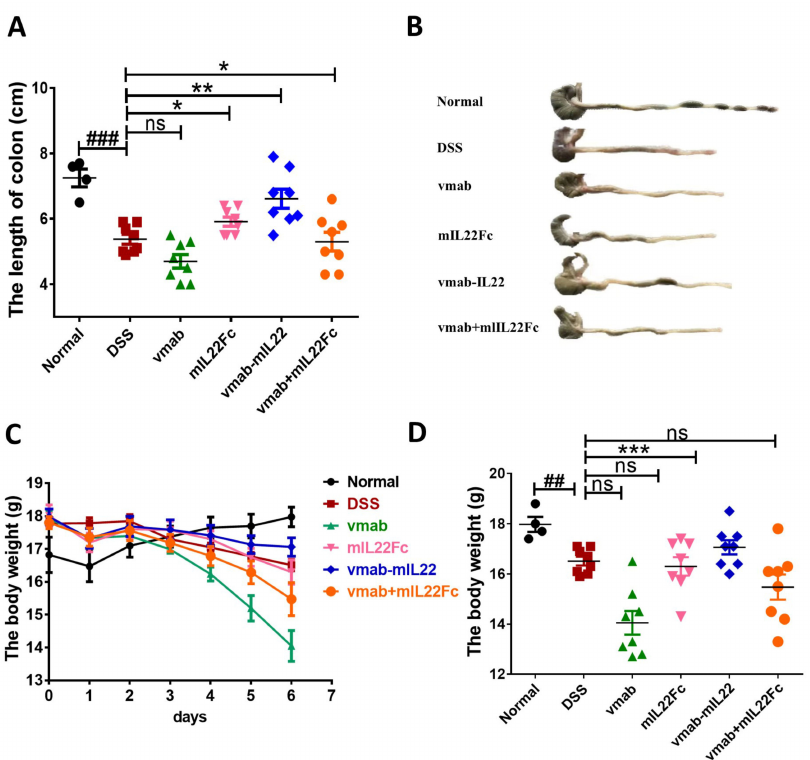
Figure 5. Vmab-mIL22 treatment reduces the damage to the colon induced by DSS in mice. Male C57BL/6 mice were treated with 2.5% DSS for 7 days, which was followed by the intravenous administration of 10.66 mg/kg vmab-mIL22 twice in 10 days. ( A ) The length of the colon at day 7 in DSS-induced colitis mice ( n = 8 for each group); ( B ) representative images of the colon at day 7 in DSS-induced colitis mice; ( C ) change in weight in DSS-induced colitis mice during the 7 days; ( D ) change in weight in DSS-induced colitis mice at day 7. ### p < 0.001, ## p < 0.01 for comparison of mice in H1N1 group to the normal group, *** p < 0.001, ** p < 0.01, * p < 0.05, for comparison of mice in treated group to the H1N1 group.